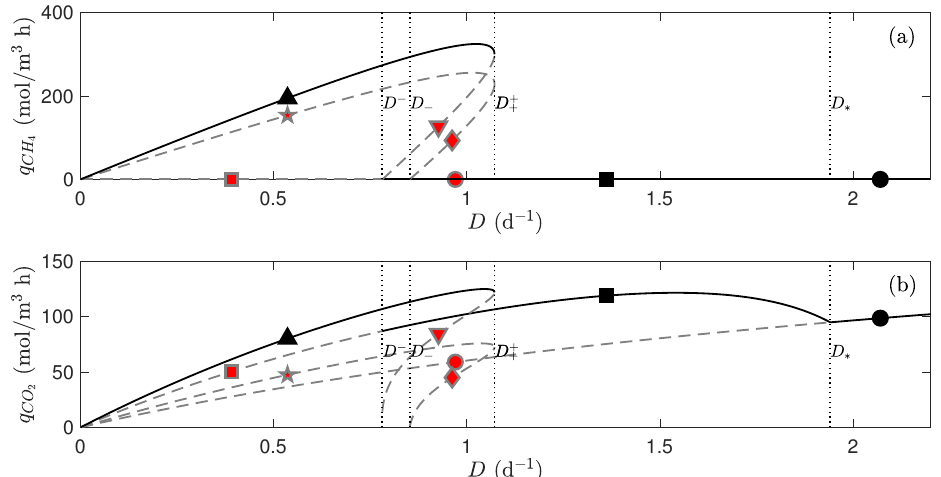
Figure 2. Bifurcation and stability analysis for gas flows of the modified AM2 model with Table 2 parameters. ( a ) Methane flow and ( b ) CO flow. The continuous lines with black markers represent 2 stable EP, the dashed lines with red markers represent unstable EP, and the dotted lines are the bifurcation points, while the shape of markers indicates the regions for each EP: = EP1, (cid:4) = EP2, (cid:7) = EP3a, (cid:70) = EP3b, (cid:72) = EP4a, and (cid:78) = EP4b. (cid:32)